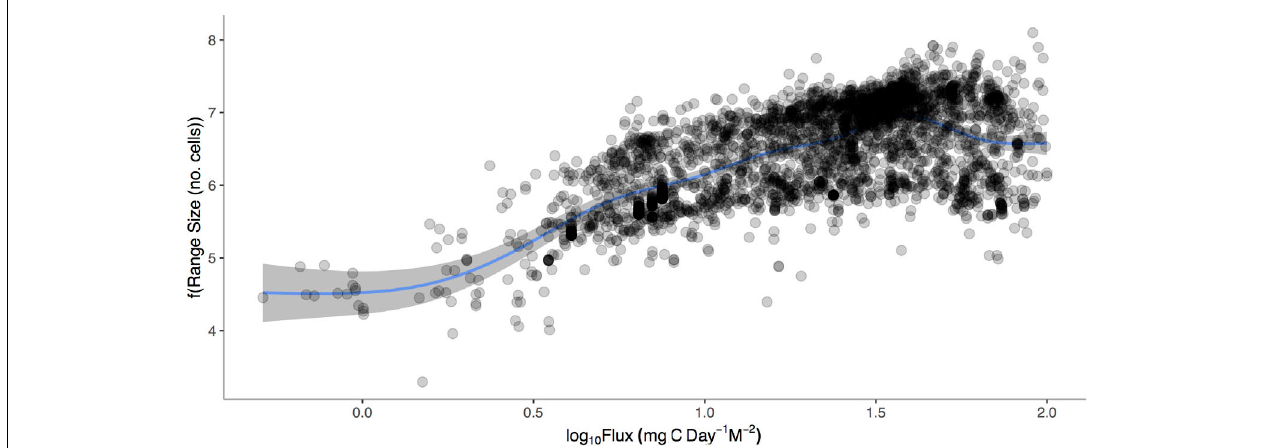
FIGURE 7 | Geographic range size (1 ◦ cells) of marine gastropods from the Atlantic Ocean verses Log 10 Mean Carbon Flux (gC m - 2 d - 1 ). General additive model relationship is shown for the conditional relationship once body size, mean depth, mean latitude, and temperature are accounted for.